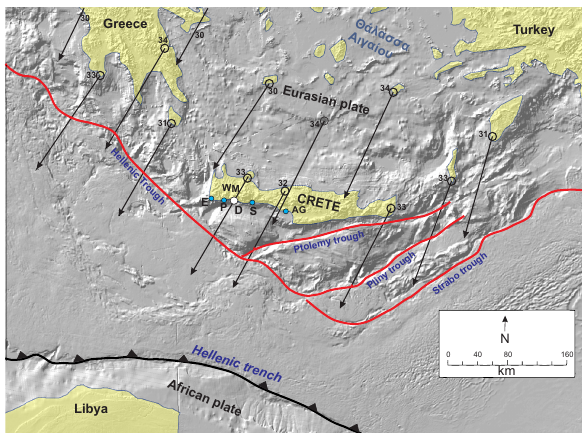
Figure 1. Map illustrating the location of Crete within the forearc of the Hellenic subduction margin. The locations of the Hellenic Trough and its splays (the Ptolemy, Pliny and Strabo troughs) are indicated. Labelled arrows show geodetically derived site velocities (mma − 1 ) relative to a fixed Nubia plate (Reilinger et al., 2010). The study area at Domata (D) is indicated by a filled white circle while the regions of Sfakia (S), Elafonisi (E), Palaiochora (P) and Agios Georgios (AG) are marked with blue circles. WM = White Mountains. Hillshade is derived from